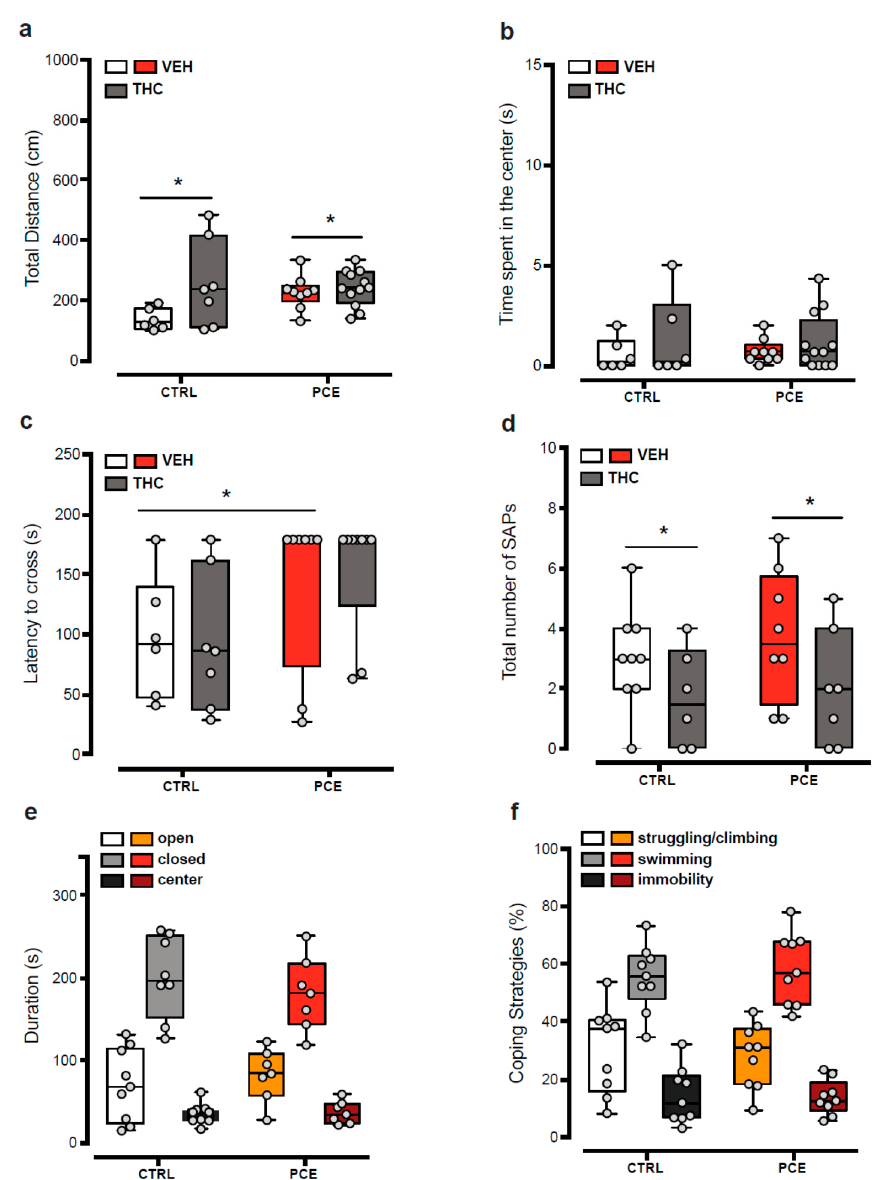
Figure 1. PCE effect on female preadolescent offspring behavior. ( a ) Spontaneous locomotor activity in female offspring, measured as total distance traveled in a novel open-field arena. Dose of ∆ 9- tetrahydrocannabinol (THC) is 2.5 mg–1 kg (s.c.) and was administered 15 min before the test ( n = 6–12/group). ( b ) Time spent (s) in the center of the open-field arena. THC or vehicle (VEH) administration does not affect the thigmotaxic behavior of prenatal cannabis exposure (PCE) females in comparison to CTRL. ( c ) The latency to crossing the wire-beam bridge is increased by PCE ( n = 7–9). ( d ) THC challenge decreases the number of stretched-attend postures (SAP) in both PCE and CTRL offspring during the wire-beam bridge test. ( e ) Behavioral responses in the elevated plus maze. No differences were found in the total duration of time spent by offspring in the closed, open arms, and center position ( n = 7–9/group). ( f ) Effect of forced swim tests (FST) on coping strategies engaged by PCE and CTRL offspring ( n = 9/group). Time spent (%) in struggling/climbing, active swimming, and immobility during the FST. All data are represented as box-and-whisker plots with single values (min to max). * p <